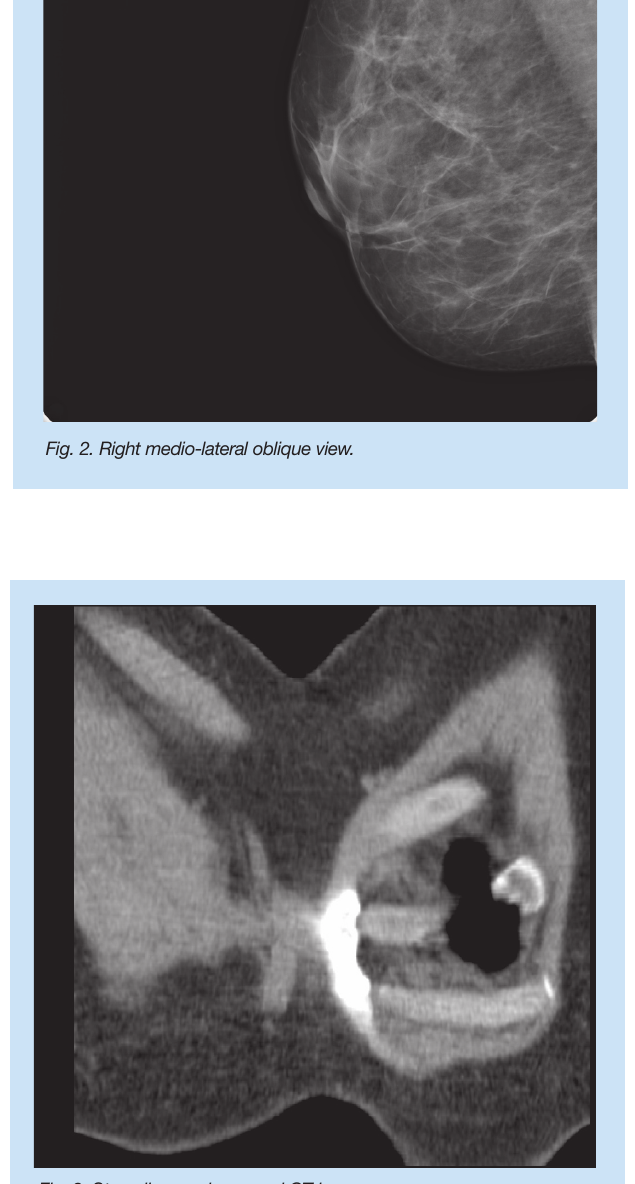
Fig. 3. Sternalis muscle coronal CT image.